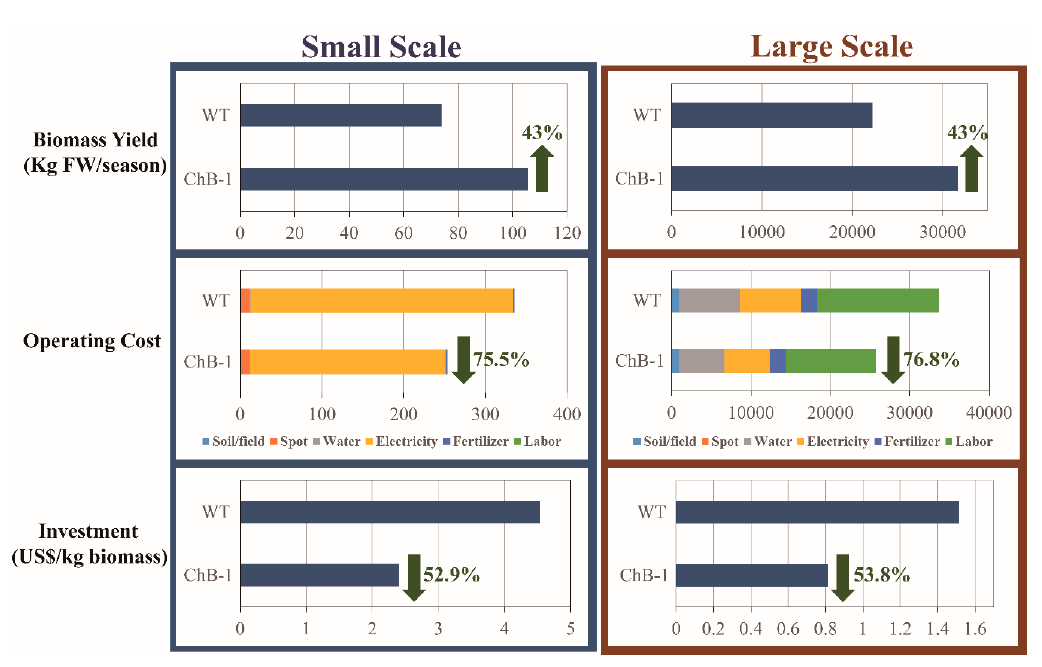
Figure 7. Comparison of the results of techno–economic assessment of investment costs of planting and biomass yield between the wild-type and transgenic tobacco plants overexpressing T. maritima BglB targeted to the chloroplasts (ChB-1 line).